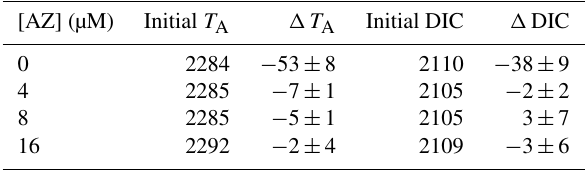
Table 1. Total alkalinity and DIC changes for every triplicate. Con- fidence interval: 1SD (taking biological variability into account).